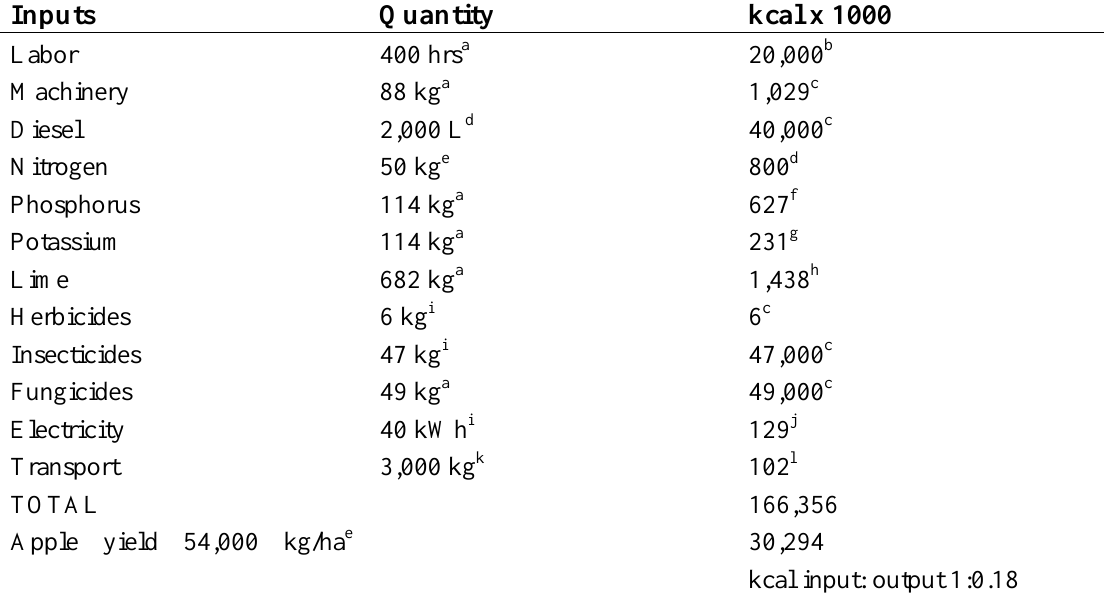
Table 15. Energy inputs of apple production per hectare in the United